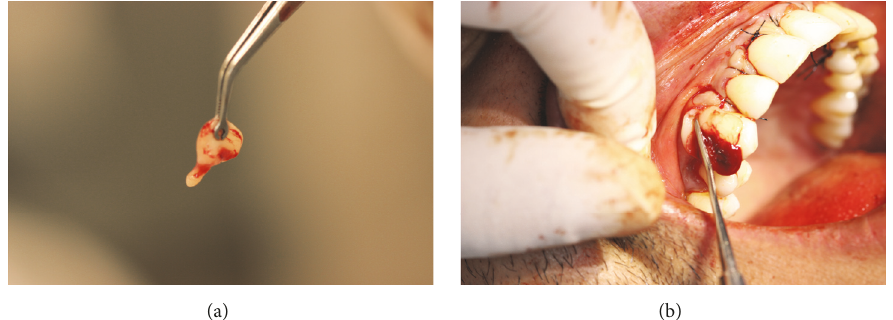
Figure 9: (a) Platelet-rich fibrin membranes. (b) Application of platelet-rich fibrin membranes on the recipient-site.